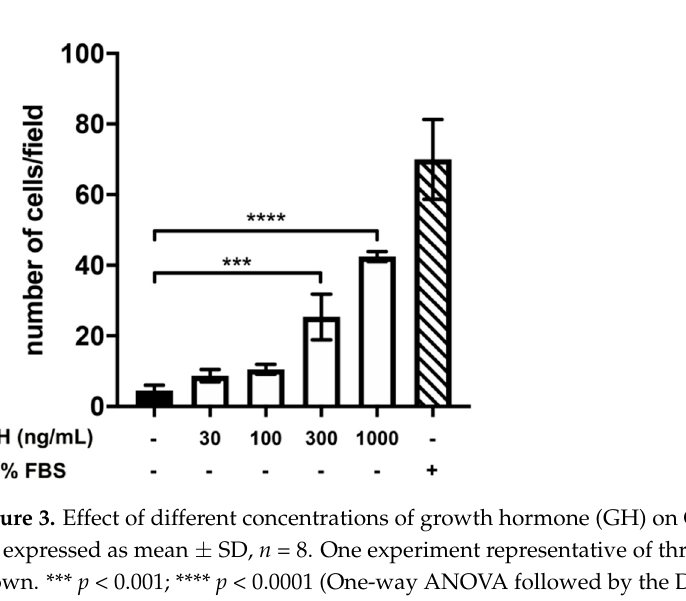
Figure 2. Effect of different concentrations of anti-Müllerian hormone (AMH) on GN11 cell migra- tion. Data are expressed as mean ± SD, n = 8. One experiment representative of three separate ex- periments is shown. ** p < 0.01; **** p < 0.0001 (One-way ANOVA followed by the Dunnett post- hoc test).